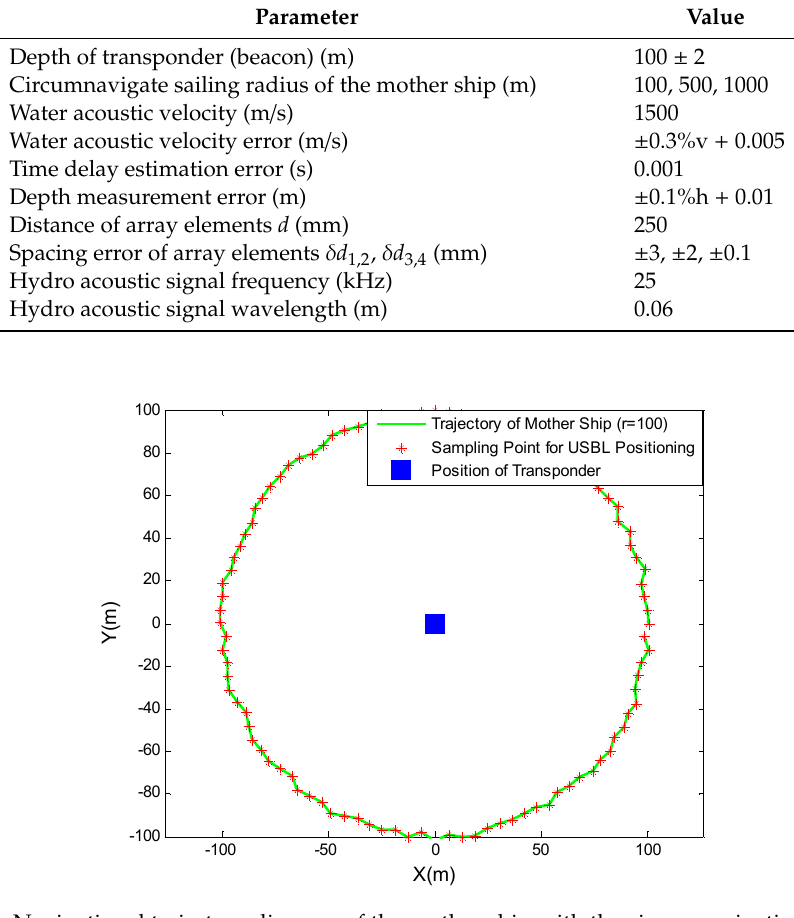
Figure 12. Navigational trajectory diagram of the mother ship with the circumnavigation radius of 100 m.